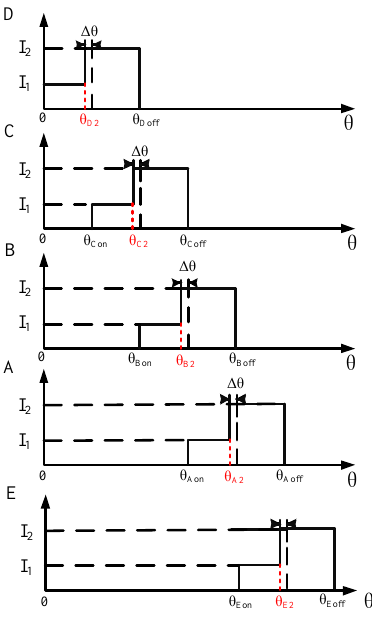
Figure 5. Proposed stepped excitation method for phase A to E